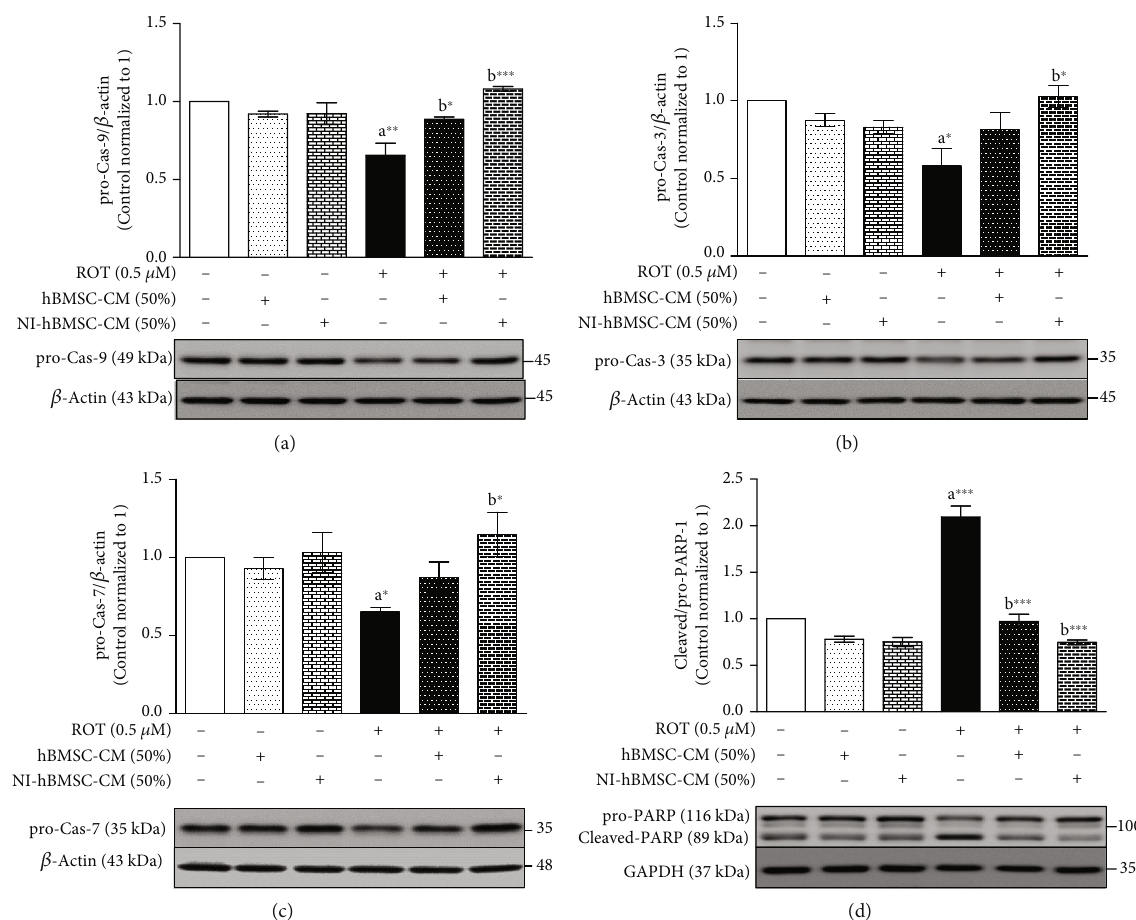
Figure 6: SH-SY5Y cells were seeded as 5 × 10 4 cells/mL of DMEM containing 1% FBS and used for experiments after overnight incubation. Cells with the absence or presence of ROT (0.5 μ M) for 48h were treated with hBMSC-CM (50%) or NI-hBMSC-CM (50%) during the last 24h and assessed for pro-Cas-9 (a), pro-Cas-3 (b), pro-Cas-7 (c), PARP (d), and β -actin or GAPDH by Western blotting. Each picture is representative of three independent experiments. Data are the mean ± SEM of three independent experiments and analyzed by one-way analysis of variance (ANOVA) followed by Tukey ’ s post hoc test. Statistical signi fi cance: a compared with control; b compared with ROT; ∗ p < 0 : 05 , ∗∗ p < 0 : 01 , and ∗∗∗ p < 0 : 001